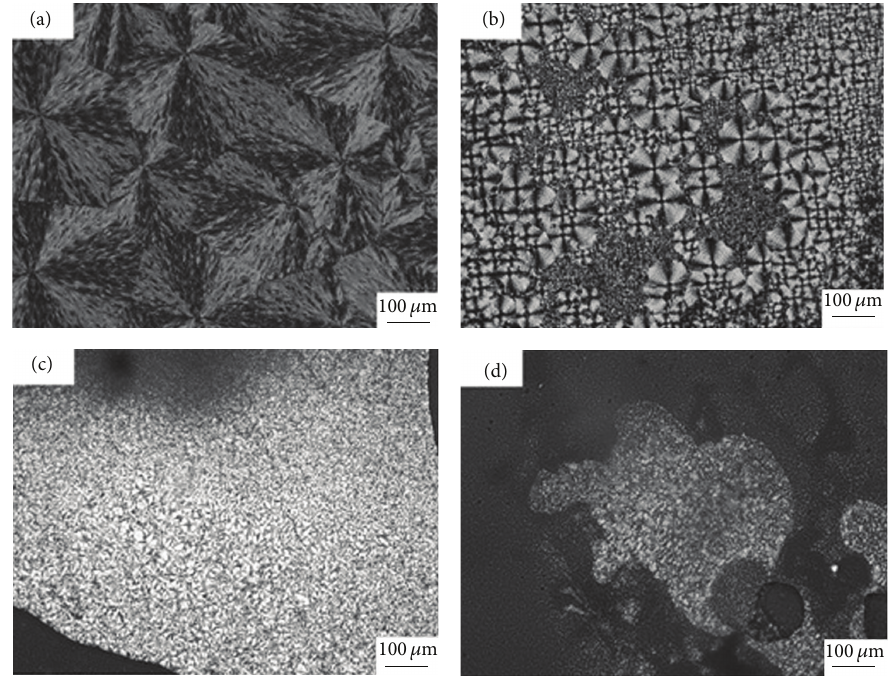
Figure 6: POM micrographs of crystallized samples (a) C0; (b) C1; (c) C2; and (d) C3.